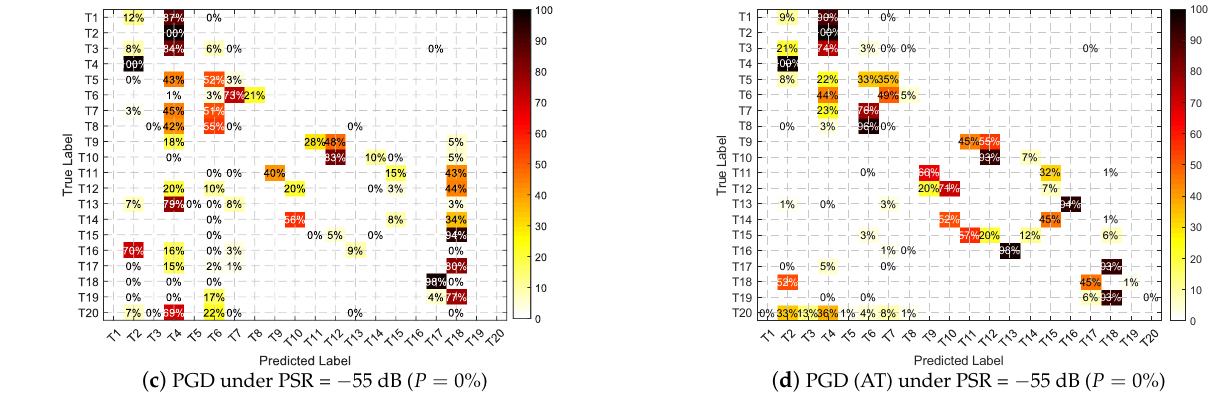
Figure 21. Recognition effect of the system with and without AT under PGD attack when SNR = 35 dB for Dataset